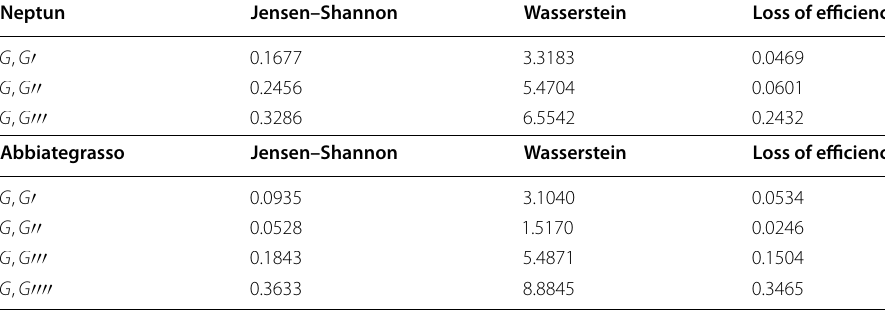
Table 3 Probabilistic distances versus loss of efficiency Neptun Jensen–Shannon